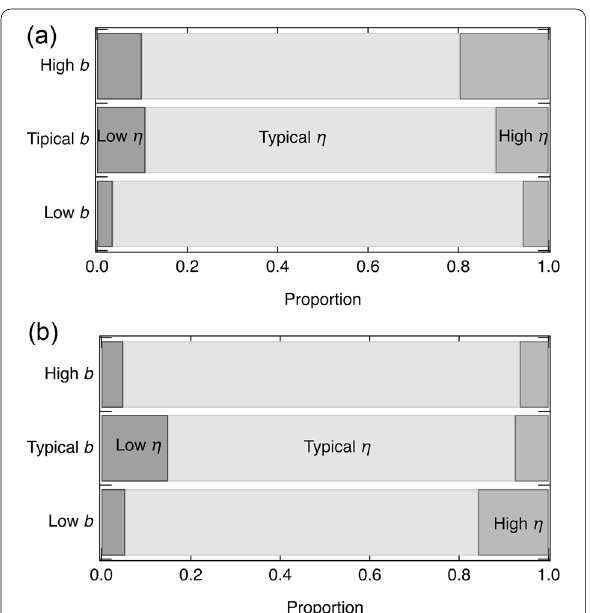
Fig. 12 Proportions of high, low, and typical η -value regions in the high, low, and typical b -value regions for N A; b area B